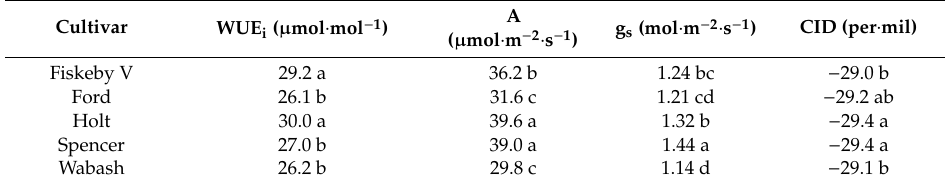
Table 4. Mean values of A, g s , WUE i , and CID values of five soybean cultivars measured on four dates in 2018. Values within columns followed by di ff erent letters were significantly di ff erent at P = 0.05, using a protected LSD test.